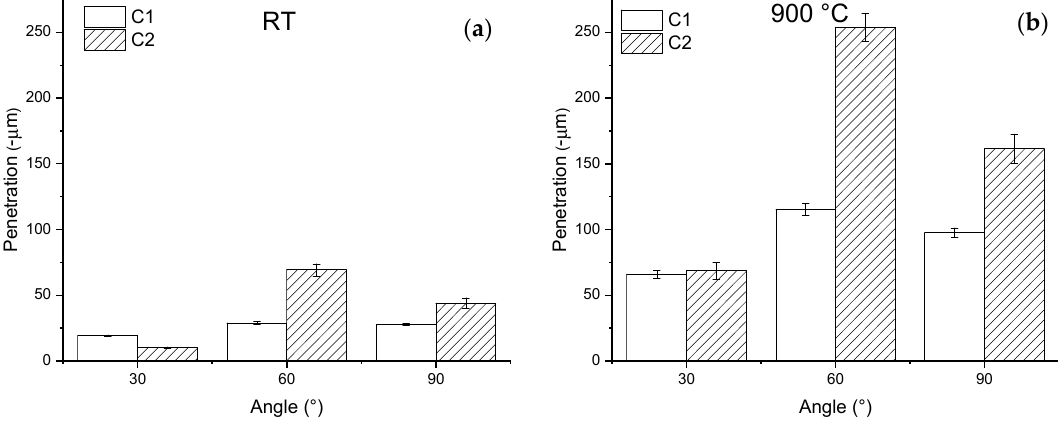
Figure 9. Average of erosion penetration plots ( a ) at room temperature and ( b ) at 900 °C.